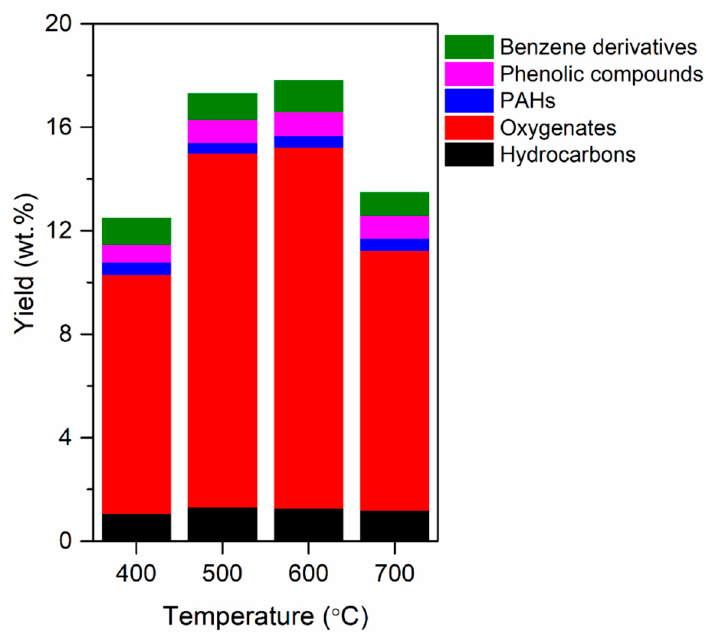
Figure 3. Yield of condensable compounds (on the basis of the weight of the feedstock) produced via the pyrolysis of TBW at different pyrolysis temperatures. Mean values of replicates ( n = 3) are reported with standard deviations of approximately 7%.